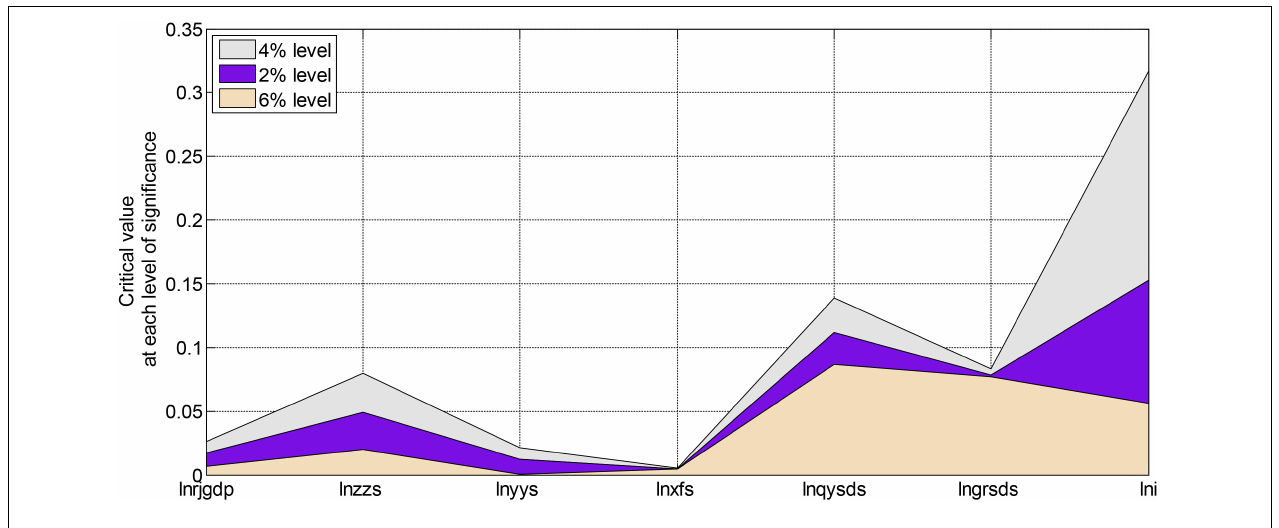
FIGURE 5 | Critical values at each level of significance.